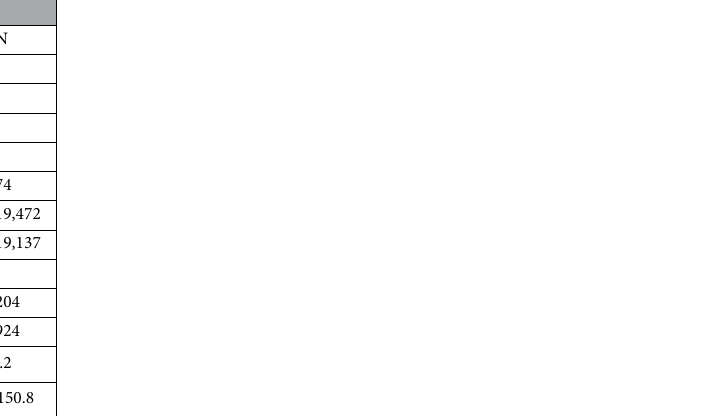
Table 2. Patient data and